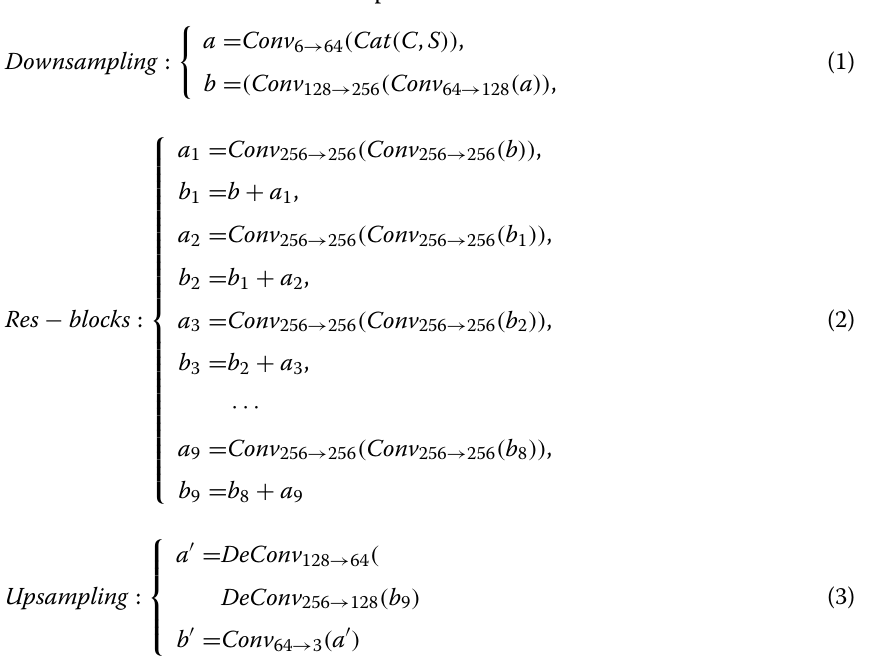
Table 2 The PSNR and SSIM value of steganograhic images and revealed secret images Stego (SSIM) Stego (PSNR) Re-secret (SSIM) Re-secret (PNSR) Deep Steganography (Baluja) 0.92 28.41 0.92 28.06 Duan’s model